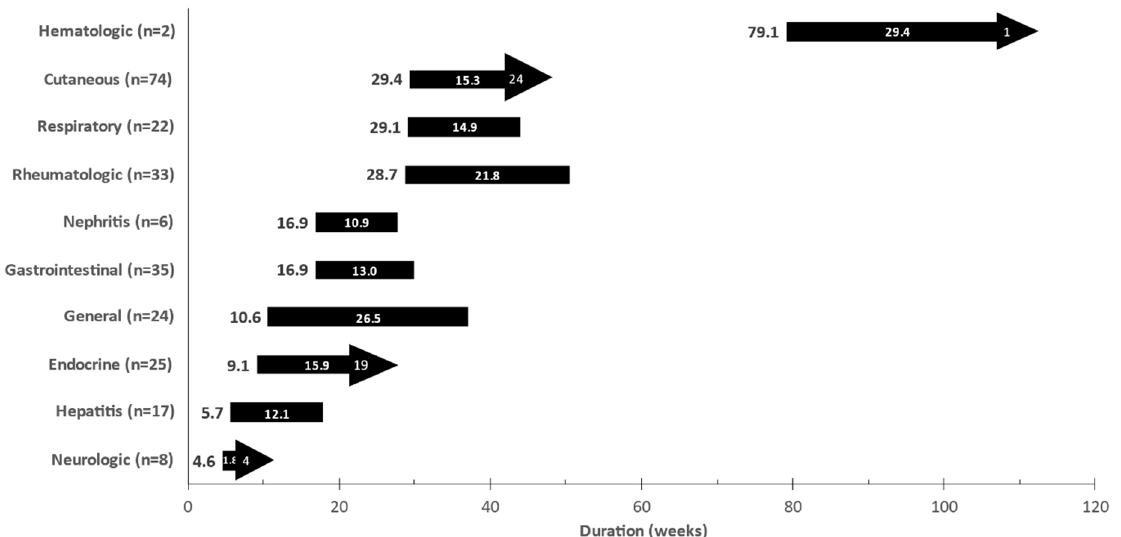
Figure 2. Time to onset and median duration of immune-related adverse events (irAE). The median time to onset of irAE from treatment initiation is shown prior to the bar (e.g., hepatitis 5.7w). The median duration of irAE is represented by the length of the bar (e.g., hepatitis 12.1w). Arrows indicate permanent adverse events. The numeric value within the arrow represents the number of patients with permanent adverse events (e.g., endocrine 19).